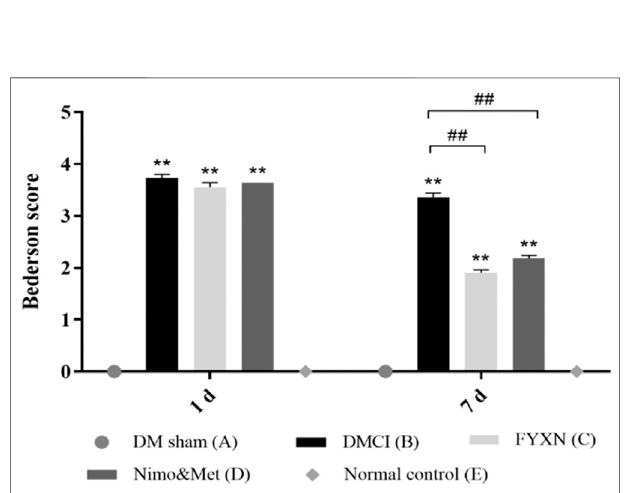
FIGURE 3 | Neurological functional results. Data of neurological de fi cit scores are shown as mean ± SD in each group. * p < 0.05, ** p < 0.01 comparedwithNCgroup;# p < 0.05,## p <